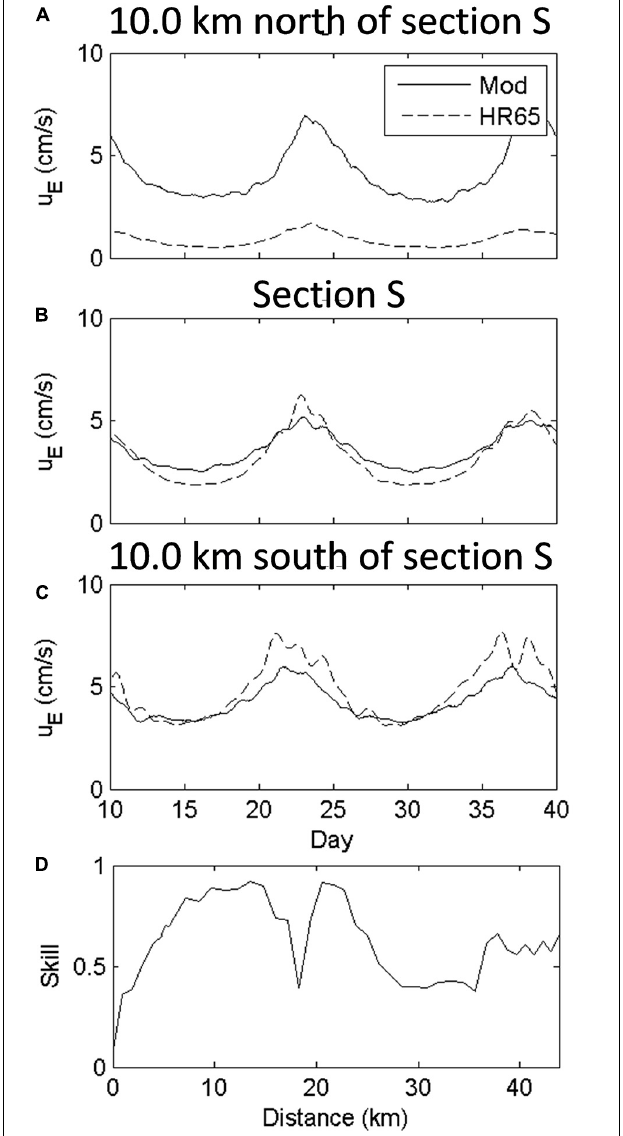
FIGURE 10 | Comparisons between prediction by theory of HR65 (dashed lines) and model simulated (solid lines) subtidal estuarine circulation at (A) 10 km north of the cross-channel section S, (B) the cross-channel section S, and (C) 10 km south of the cross-channel section S. (D) The prediction skill distribution along the western channel. The x-axis represents the distance from the mouth (0 km) to the head (44 km) of the